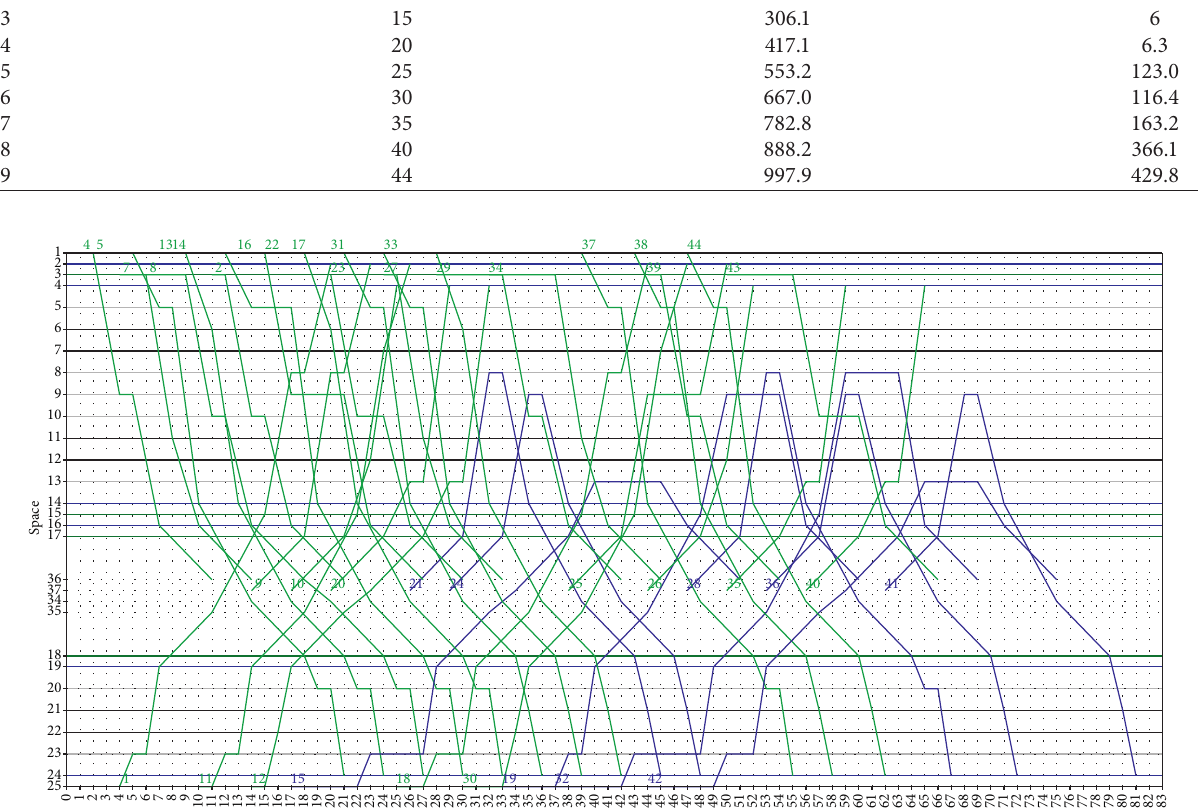
Figure 7: Train timetabling and platforming result for Line 1.